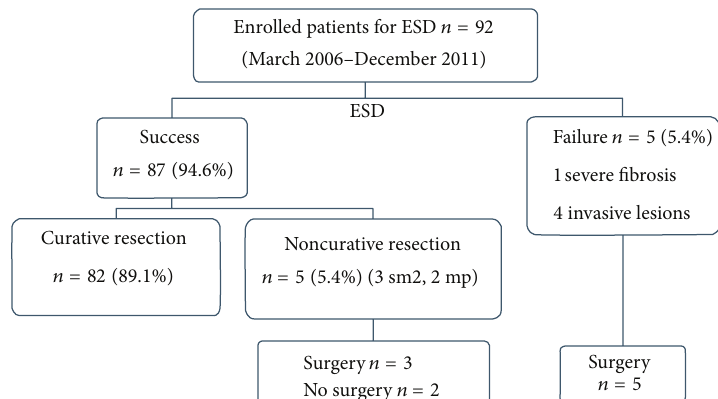
Figure1:PatientsandESDoutcomes.ESD:endoscopicsubmucosaldissection;sm2:submucosalinvasion ≥ 1000 𝜇 m;mp:muscularispropriae